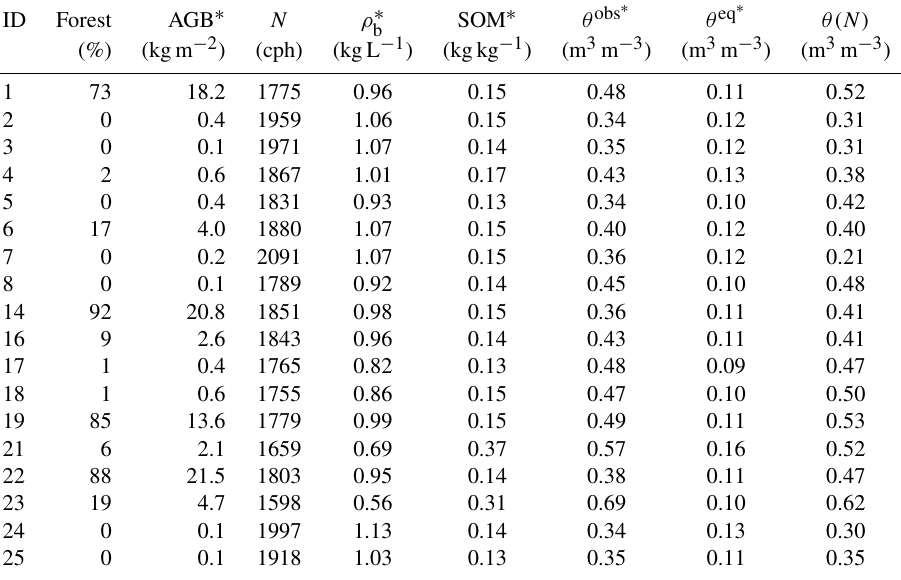
Table 2. Overview of calibration data and results per sensor (variables with an asterisk ( ∗ ) were computed as a weighted average per footprint). ID: sensor ID; Forest: percentage of forest area in the footprint; AGB: above-ground dry matter biomass; N : corrected neutron count rate averaged over the calibration period; ρ b : soil bulk density (note that vertical weighting gives more weight to the top soil, where the bulk density tends to be lower; cf. Sect. 4.1.4 and Fig. S2); SOM: soil organic matter content; θ obs : volumetric soil water content